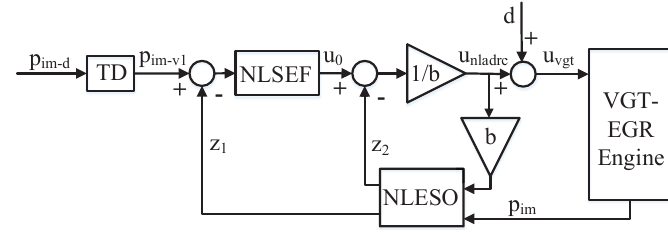
Figure 3. The structure of NLADRC controller for p im loop in VGT-EGR diesel